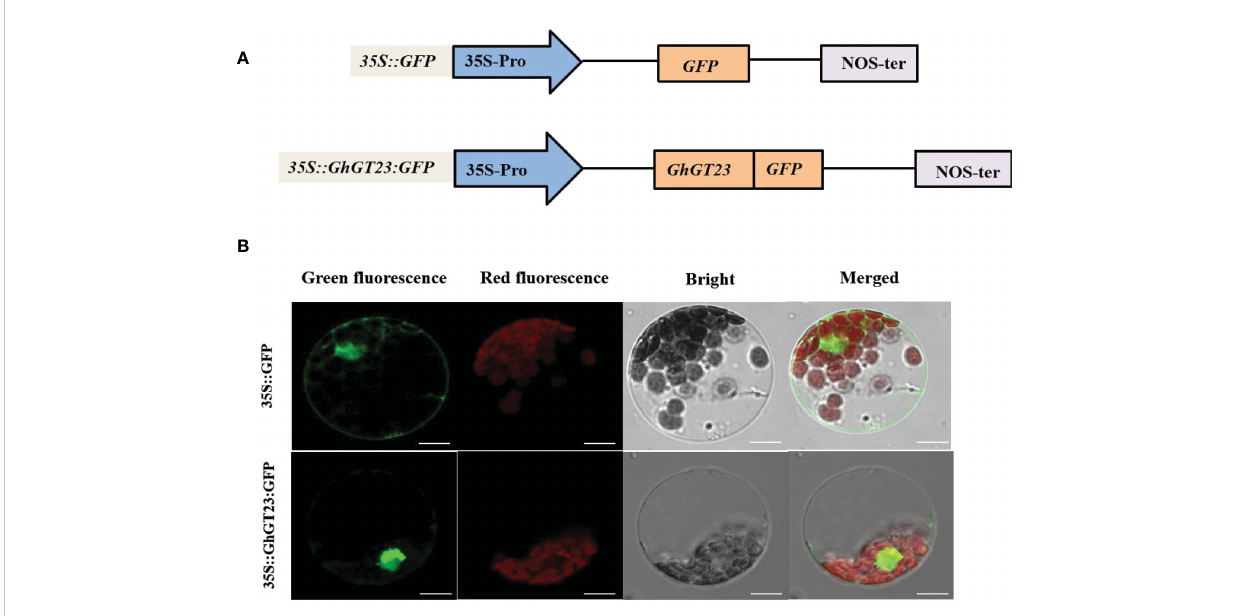
FIGURE 4 The subcellular localization of GhGT23 in Arabidopsis protoplasts. (A) Diagram of the GFP-fusion vector ( 35S::GhGT23:GFP ) and control construct ( 35S::GFP ) used in Arabidopsis protoplast transfections. (B) Transient expression of 35S::GhGT23:GFP and free 35S::GFP in Arabidopsis protoplasts. Green fl uorescence from free GFP and GhGT23:GFP protein accumulation can be seen in the nucleus and cytoplasm of protoplasts. Chlorophyll auto fl uorescence is shown in red, and the periphery of the protoplasts can be seen in the bright fi eld images. Images were taken using a laser